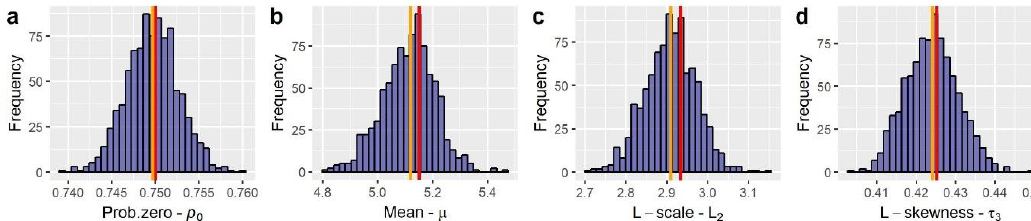
Figure 8. Comparison between RF’s target and simulated key statistics, particularly: ( a ) probability dry; ( b ) mean; ( c ) L-scale; and ( d ) L-skewness.